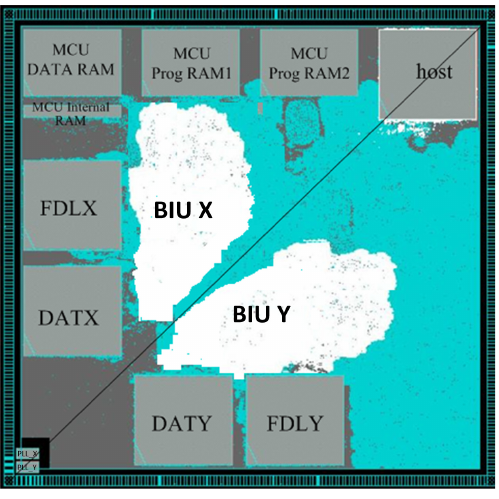
Figure 4. Layout of the proposed bus